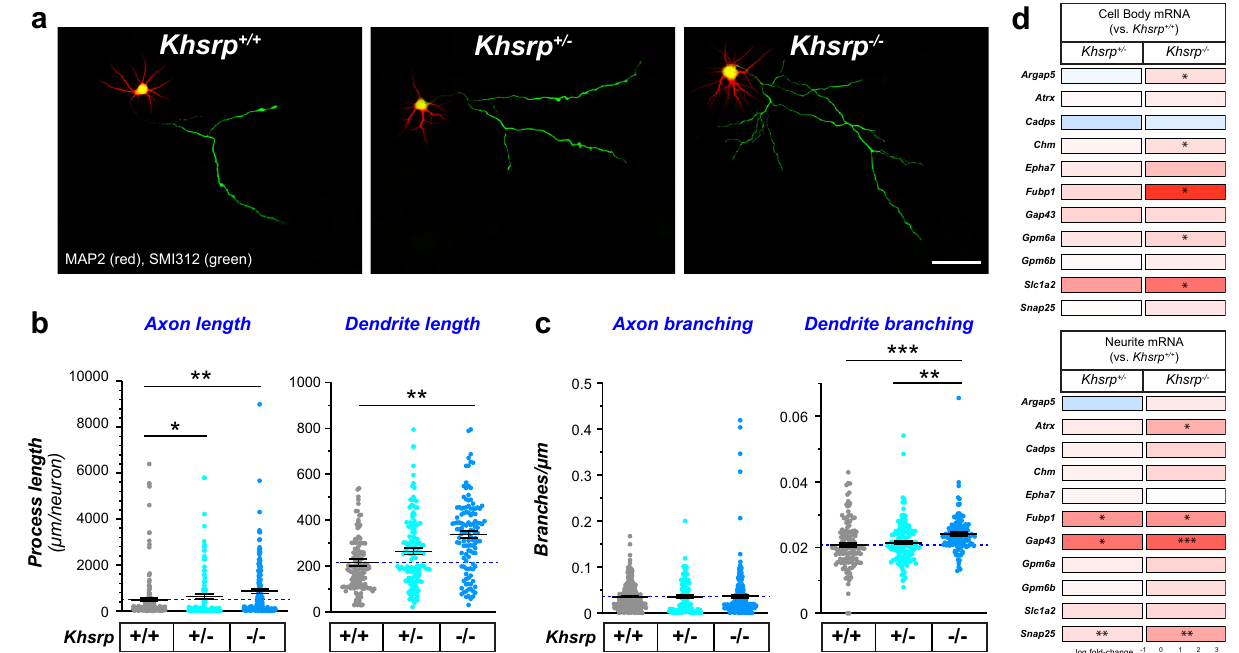
Fig. 3 Neocortical neurons cultured from KHSRP de fi cient mice show increased axonal and dendritic growth. a Representative micrographs for neocortical neurons from Khsrp + / + , Khsrp + / − , and Khsrp − / − littermates shown for DIV7 cultures as indicated. b , c Axon and dendrite lengths ( b ) and branch densities ( c ) are displayed as means ± SEM ( N ≥ 75 neurons analyzed over at least three separate cultures preparations; * p ≤ 0.05, ** p ≤ 0.001, and *** p ≤ 0.005 by one-way ANOVA with Tukey post-hoc). d Heat map for levels of KHSRP-target mRNAs linked to axon growth and neuronal morphology for cell body and neurite RNA analyses. Data are displayed as log 2 fold-change relative to Khsrp + / + cortical cultures ( N ≥ 4 culture preparations; * p ≤ 0.05, ** p ≤ 0.001, and *** p ≤ 0.005 vs. Khsrp + / by two-tailed Student ’ s t test). See Supplementary Fig. 3 for parallel analyses in hippocampal neuron cultures and Supplementary Data 5 for mRNA copy number from these analyses [Scale bar = 100 µ